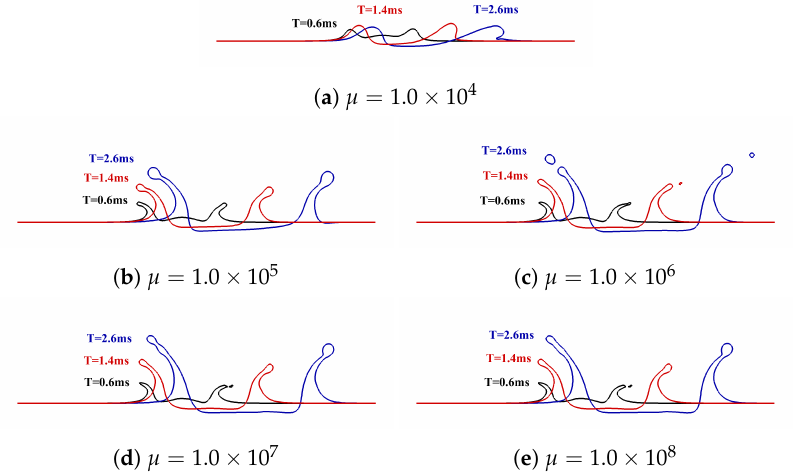
Figure 16. Interface of a drop impingement onto a dynamic film at different viscosity when θ = 30 ◦